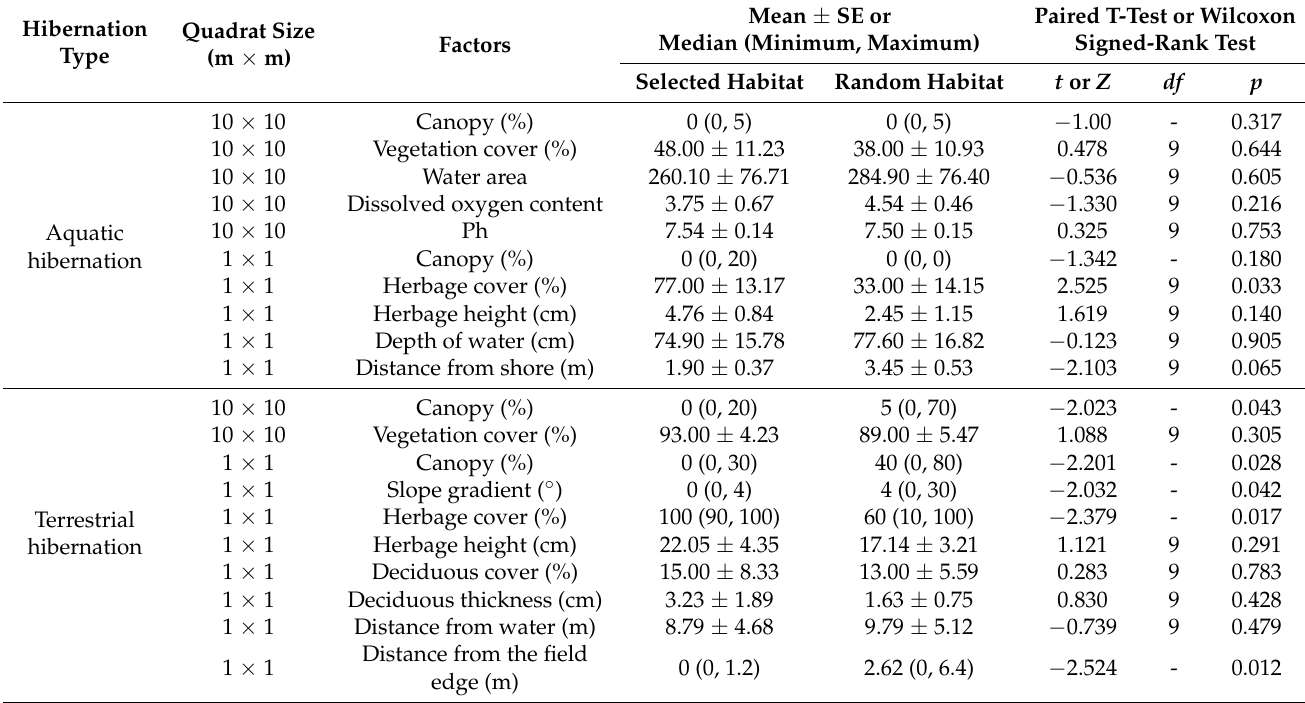
Table 2. Ecological factors between selected and random quadrats in hibernating Reeves’ turtles in Qichun County, Hubei Province,